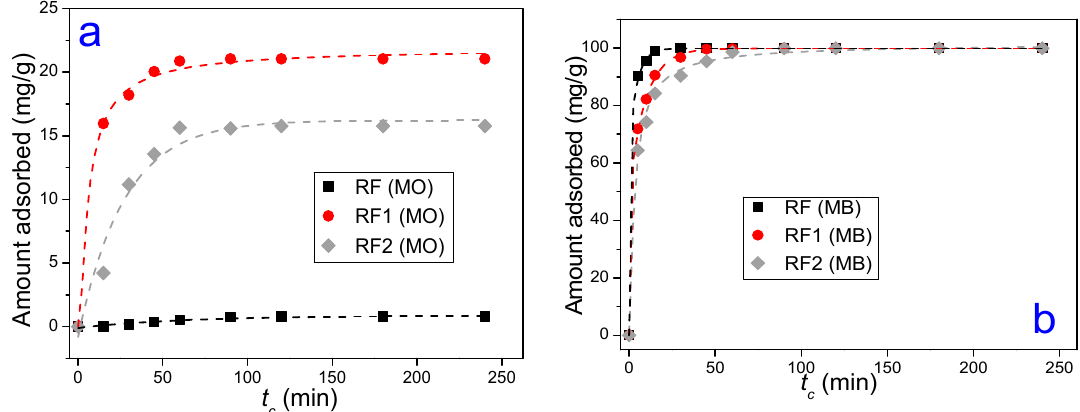
Figure 5. Effect of contact time ( t c ) on ( a ) MO adsorption and ( b ) MB adsorption. The lines are only guides for the eyes.